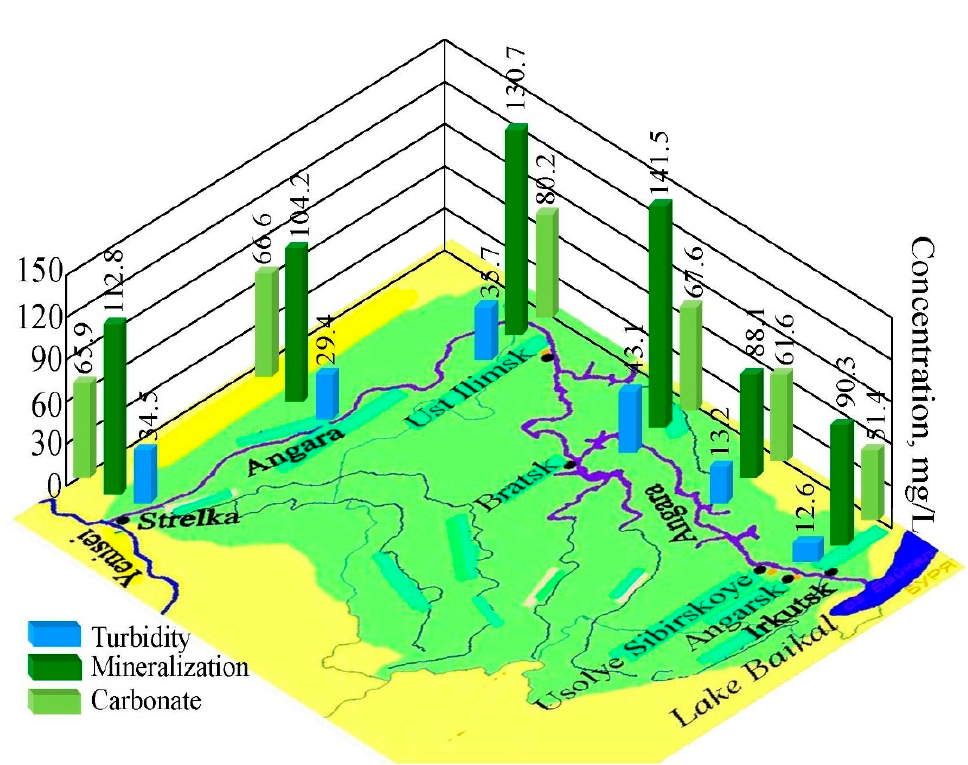
Table 6. Model evaluation of the hydrochemical characteristics of water delivered from the Yenisei River to the Kara Sea. Distance from the Angara Junction (Strelka) to Kara Sea, km